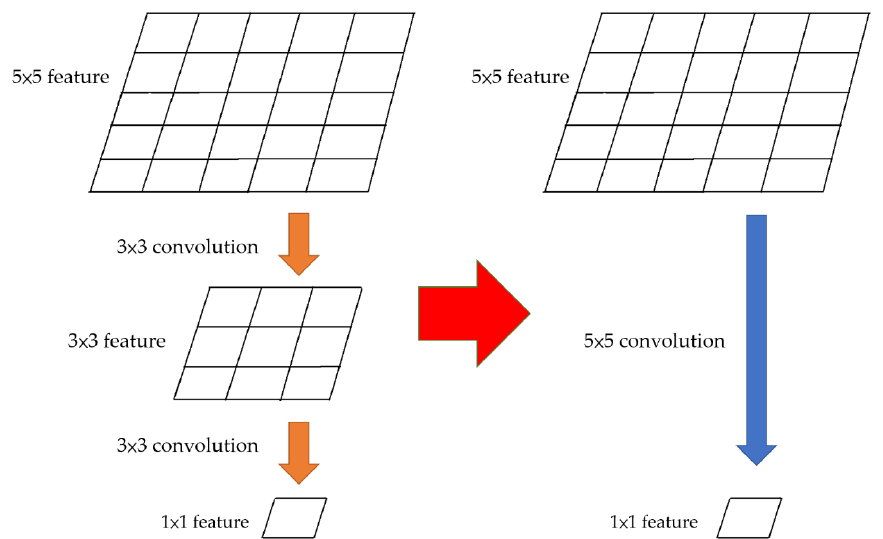
Figure 4. A 5 × 5 feature can be aggregated into 1 × 1 feature after two 3 × 3 convolutions or a 5 × 5 convolution.